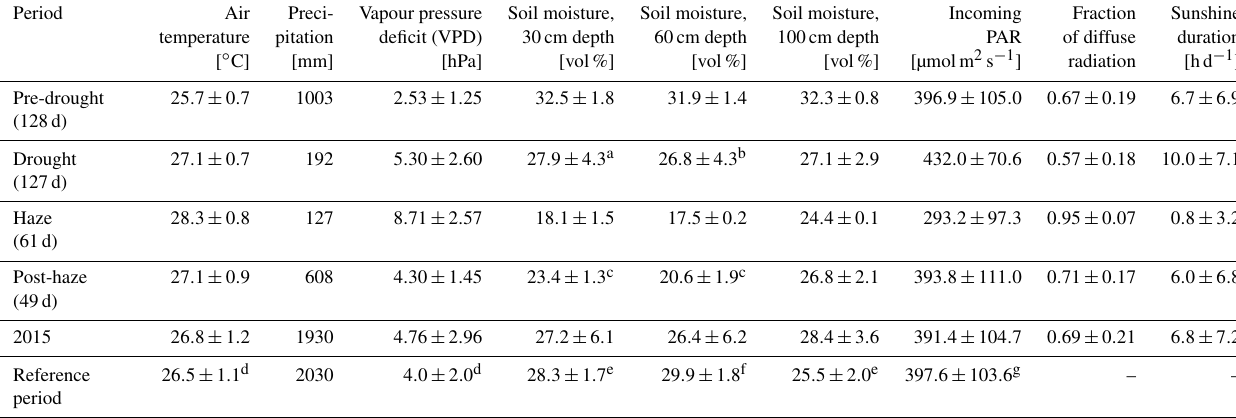
Table 1. Meteorological parameters (daily mean ± SD, or accumulated for precipitation and carbon) derived from 30min averages or sums during the pre-drought, non-haze drought, haze drought and post-haze periods in 2015; for the entire year 2015; and the reference period